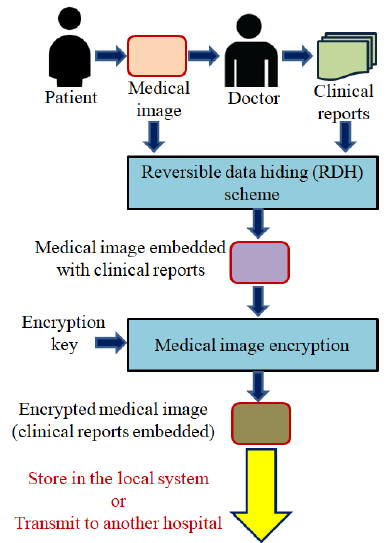
Figure 2. Overview of RDH scheme to embed clinical reports in medical images. An RDH method to use in this domain should have the following